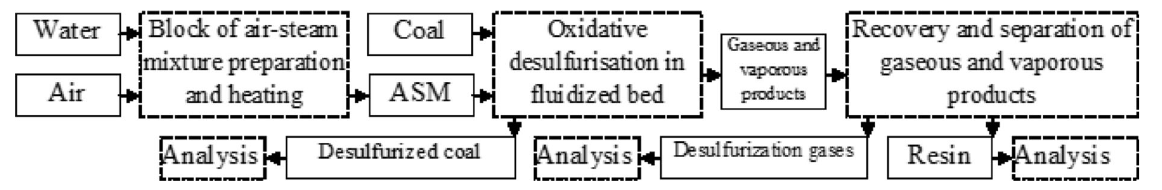
Fig. 1 Block diagram of the laboratory plant for coal